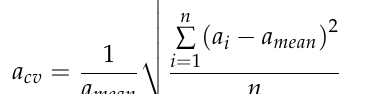
Figure 5. Schematic diagram of maximum point of simulation results.